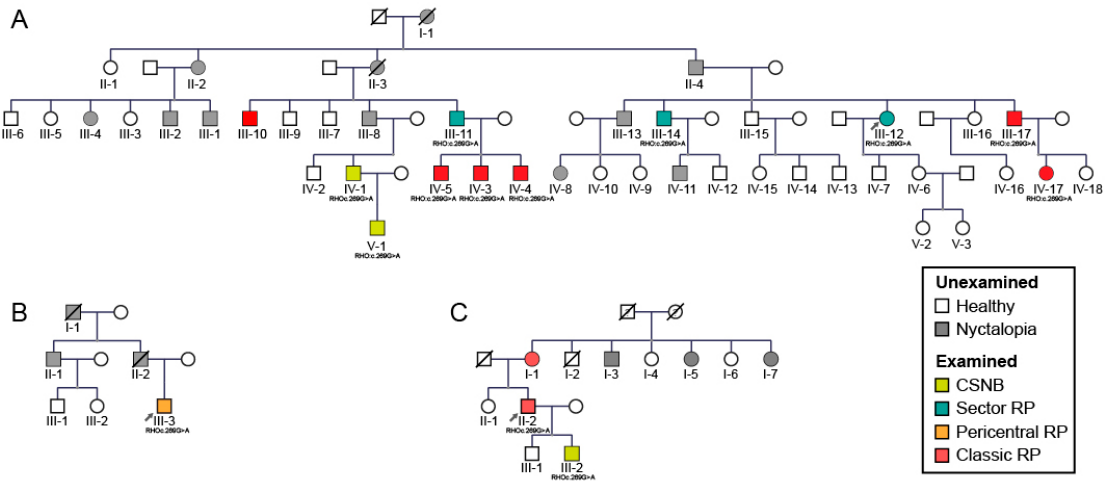
Figure 1. Pedigrees of three families ( A – C ) with the p.G90D mutation in rhodopsin gene (RHO). Patient ID is shown underneath each symbol. Different phenotypes are shown in different colors. Unexamined affected family members are shown with grey symbols. Male subjects are indicated by squares and female subjects by circles. Arrows mark the index patient of each family which was diagnosed by whole exome sequencing while other examined patients had targeted sanger sequencing for the p.G90D variant. Roman numerals indicate generation while Arabic numerals indicate individuals in each generation. Abbreviations: CSNB—congenital stationary night blindness, RP—retinitis pigmentosa.